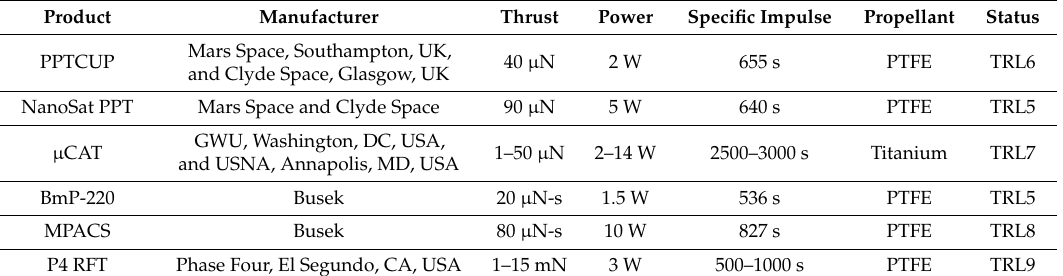
Table 12. Performance Data of off-the-shelf Pulse Plasma Thrusters and Vacuum Arcs [23,38].